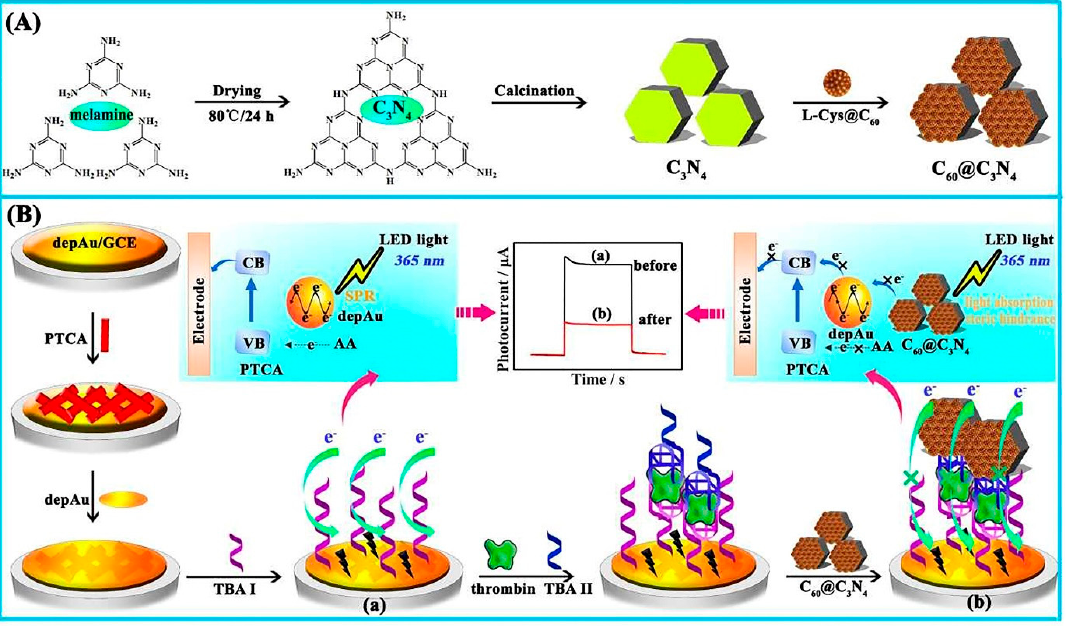
Figure 8. The photoelectrochemical aptasensor for TB determination. ( A ) The synthesis of C 60 @C 3 N 4 nanocomposites, and ( B ) the signal-off PEC aptasensor fabrication mechanism [128]. nanocomposites, and ( B ) the signal-off PEC aptasensor fabrication mechanism A Ag-TiO 2 3D nitrogen-doped graphene hydrogel (3DNGH) was synthesized